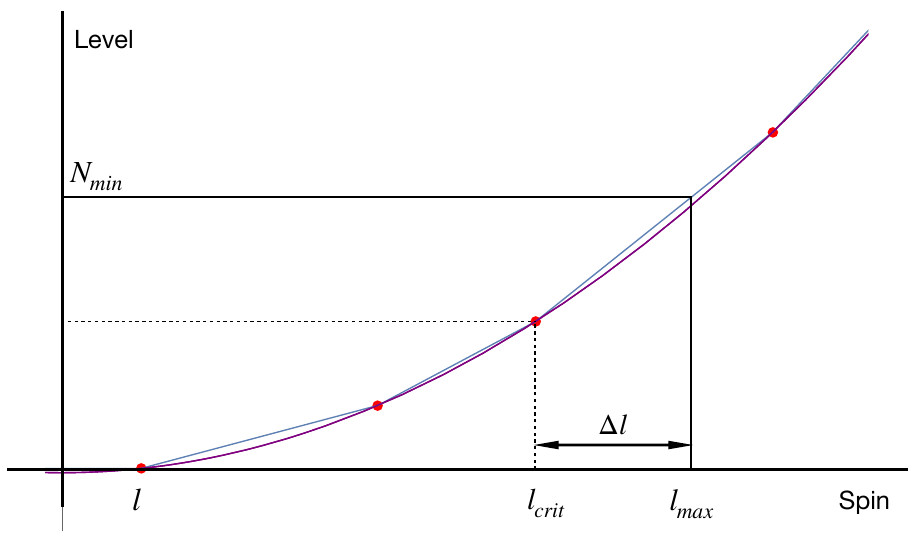
Figure 4 . We show the right quadrant of the weight diagram of an irreducible su (2) current algebra module and indicate all the variables that appear in the various